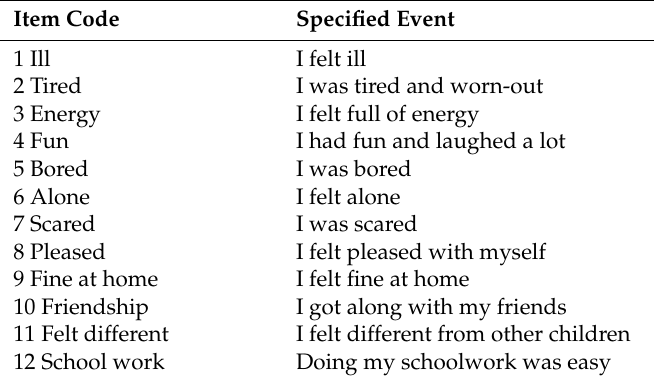
Table 1. Items from the HRQoL